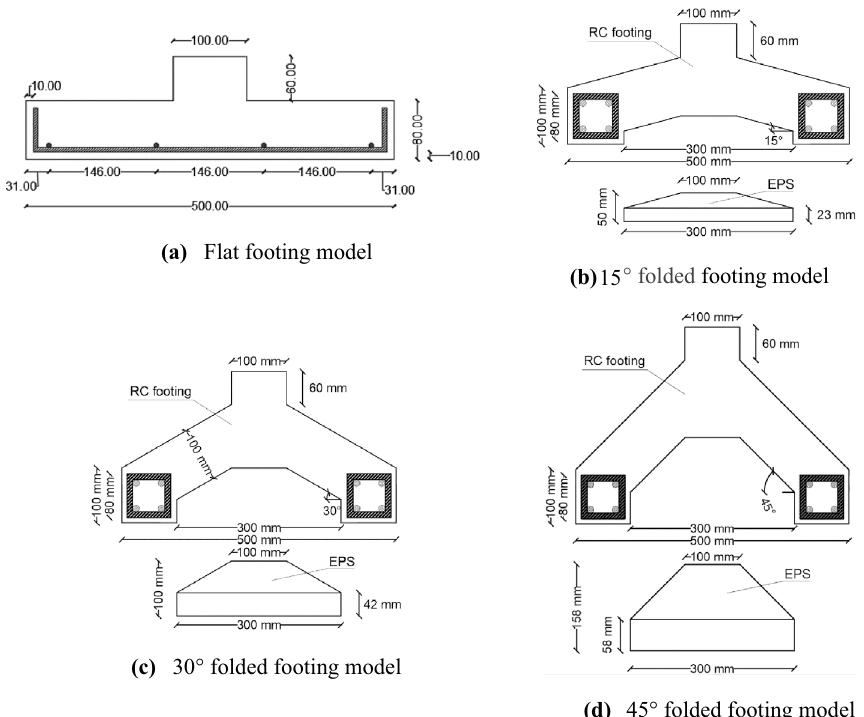
Fig. 2 Geometry and reinforcement of the footing models ( a ) flat footing, ( b ) folded 15 o , ( c ) folded 30 o ,